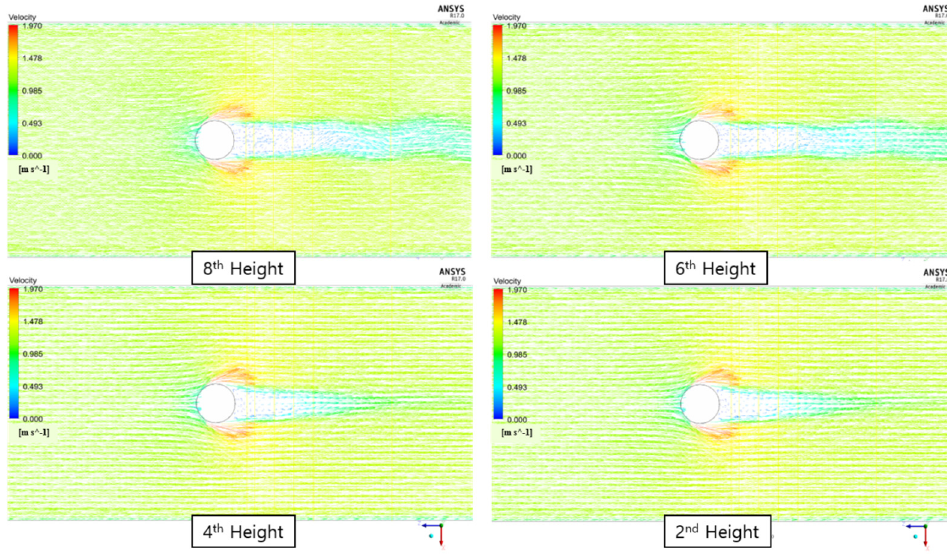
Figure 8. Time-averaged streamlines in different x–z planes.